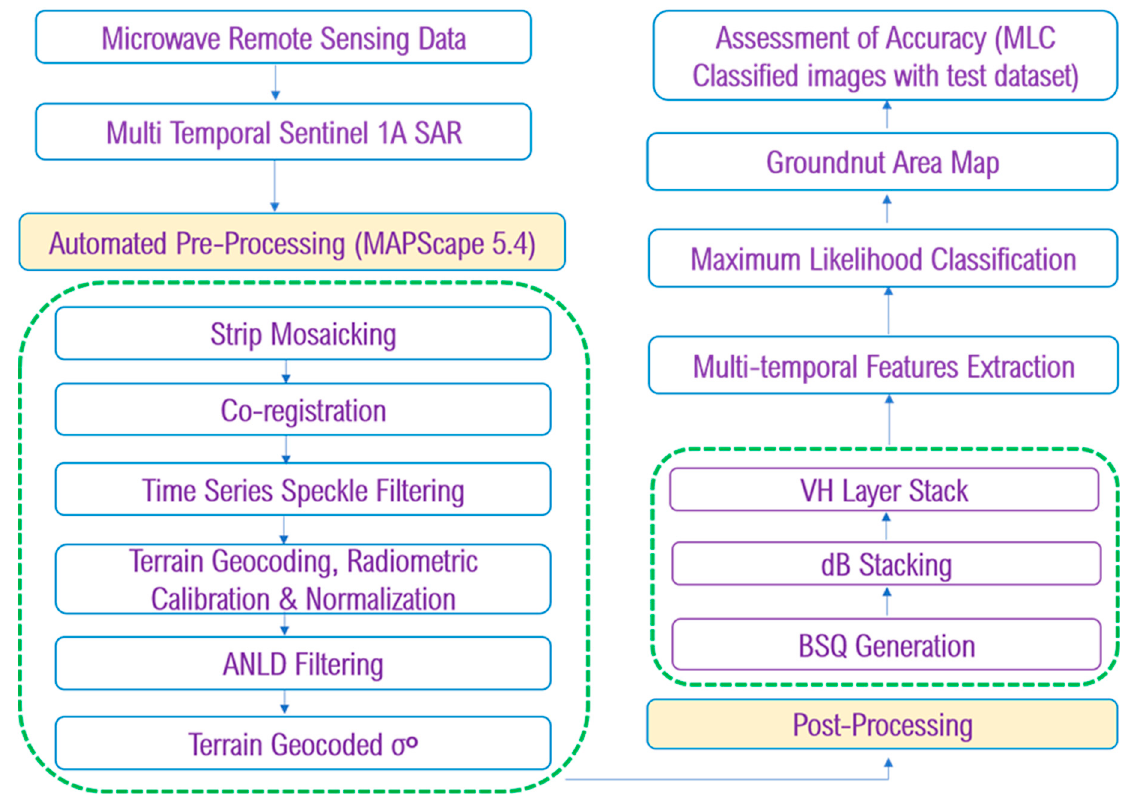
Figure 2. Flow chart for methodology of SAR data processing and peanut area mapping.